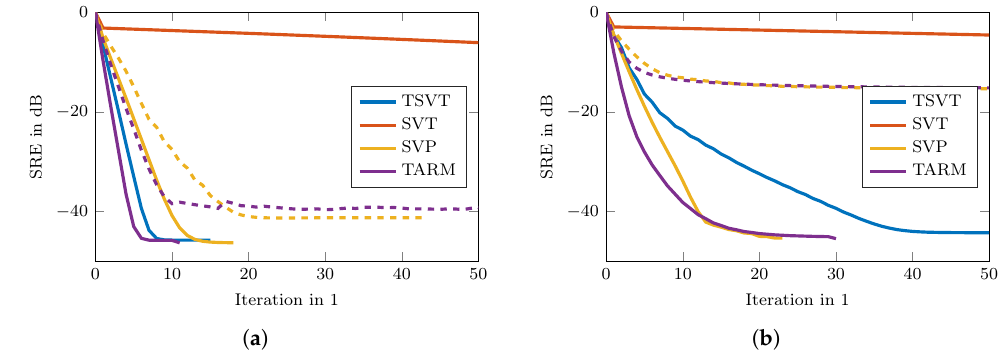
Figure 11. Comparison of convergence speed for d ρ / m = 0.25 and m / n = 0.5. The solid lines show SVP and TARM for R = ρ and the dashed lines for R = 2 ρ . ( a ) Random sensing operators A ∼ CN ( 0,1 ) . ( b ) DFT sensing operators with random